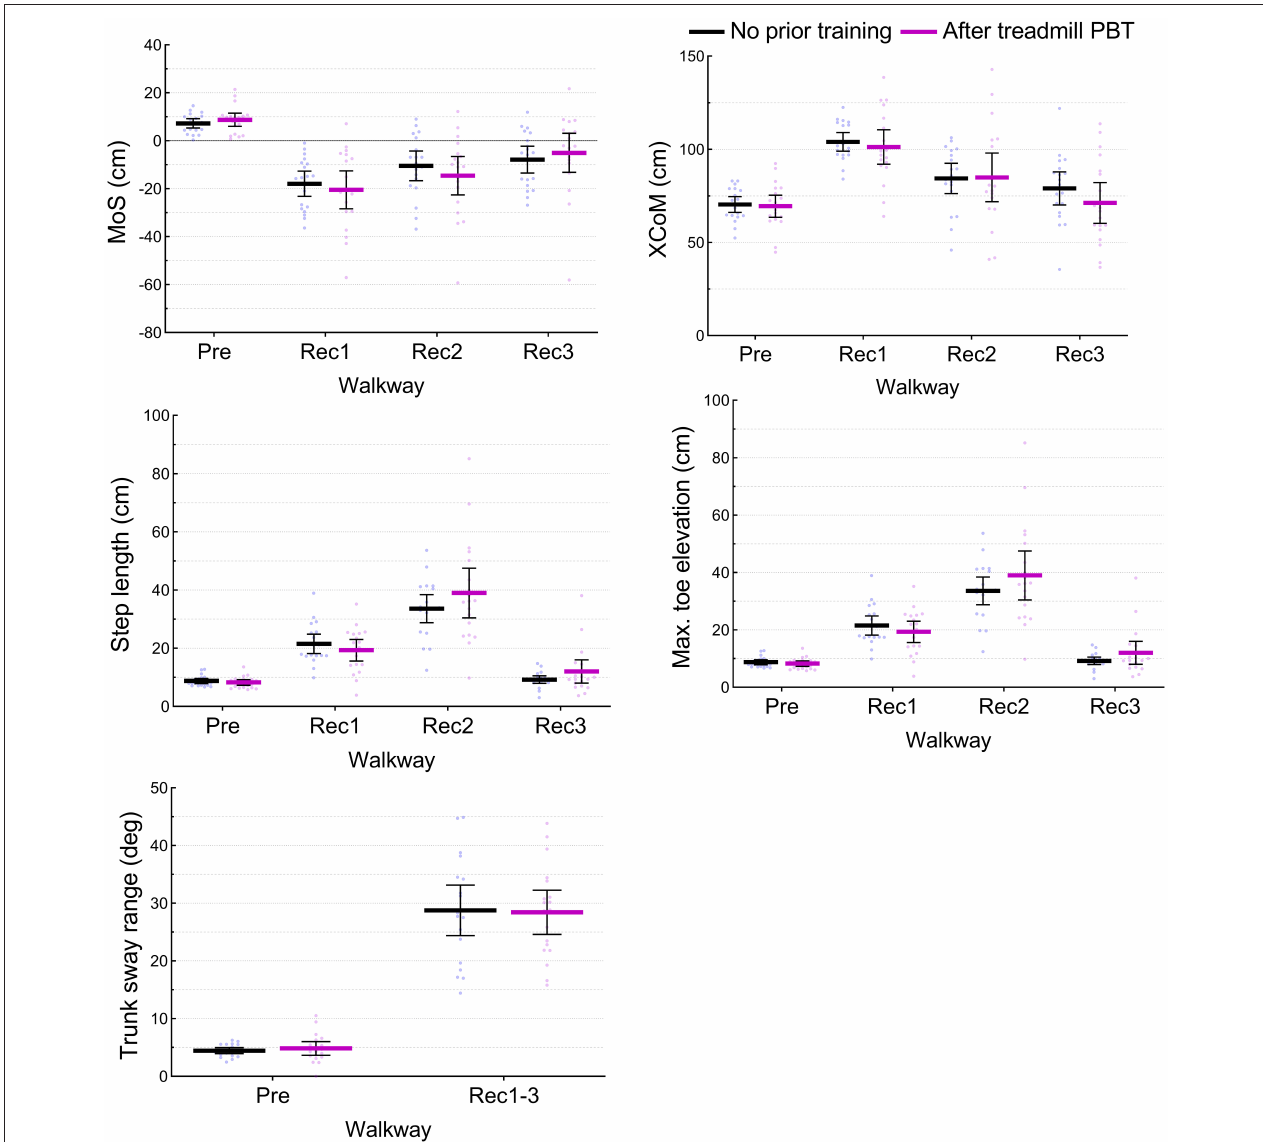
FIGURE 4 | Test of transfer from treadmill PBT to an actual trip. Kinematic parameters at one previous (Pre) and three recovery (Rec1, Rec2, and Rec3) steps during the first walkway trip (T1) were compared between Group T-W (who had previously completed treadmill PBT) and Group W-T (who had no prior training). The mid lines and error bars represent means and 95% confidence intervals. No significant differences were detected ( P >